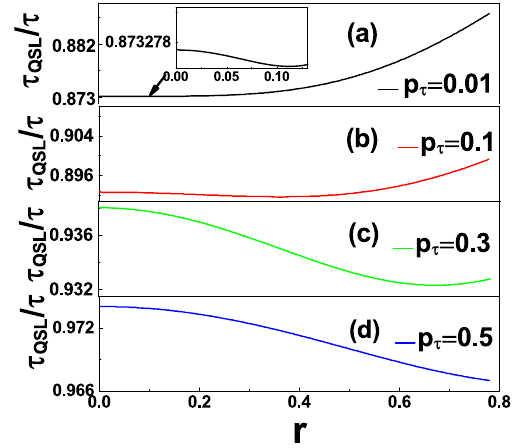
Fig. 1 QSLT for a given two-qubit state, quantified by τ QSL /τ as a function of the acceleration parameter r , when both Alice and Bob’s states are in the ADC. We set q R = 1